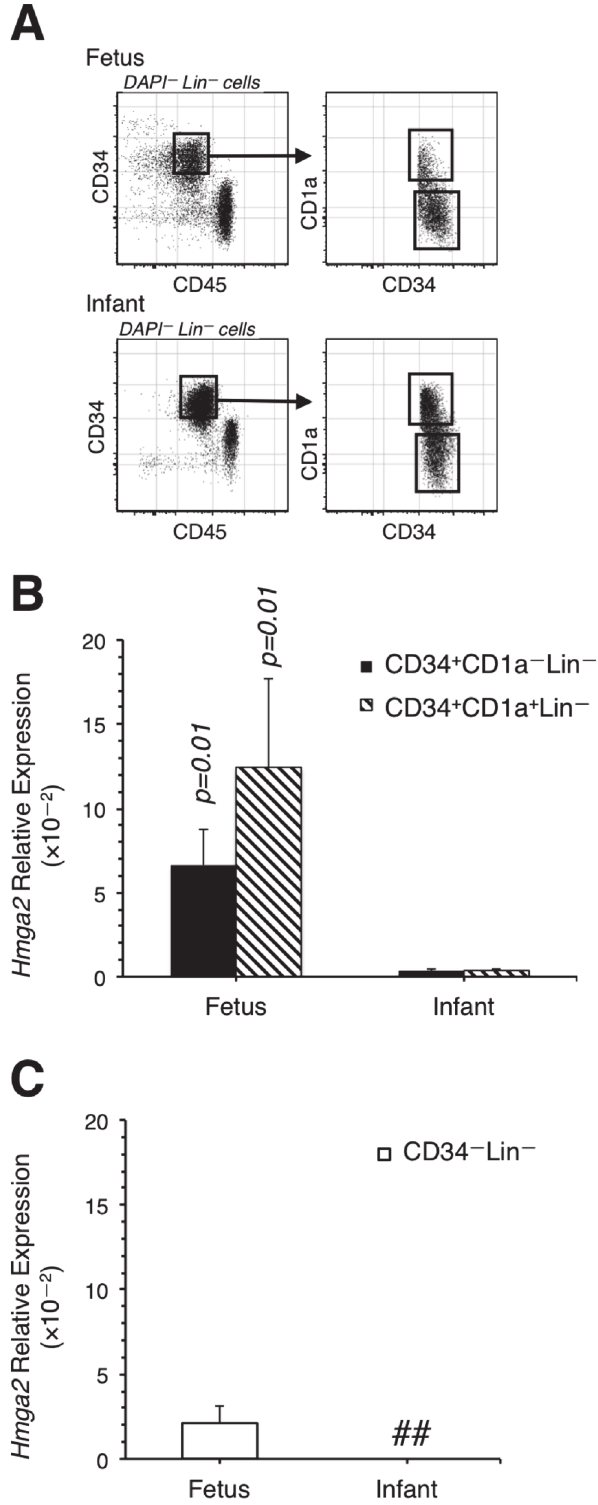
Fig 3. Hmga2 expression is higher in human fetal versus infant thymic progenitors. (A) FACS plots showing the resolution of human lineage negative T cell progenitors according to CD34 and CD1a expression. The plots are representative of two independent sorts for each sample. (B) Expression of